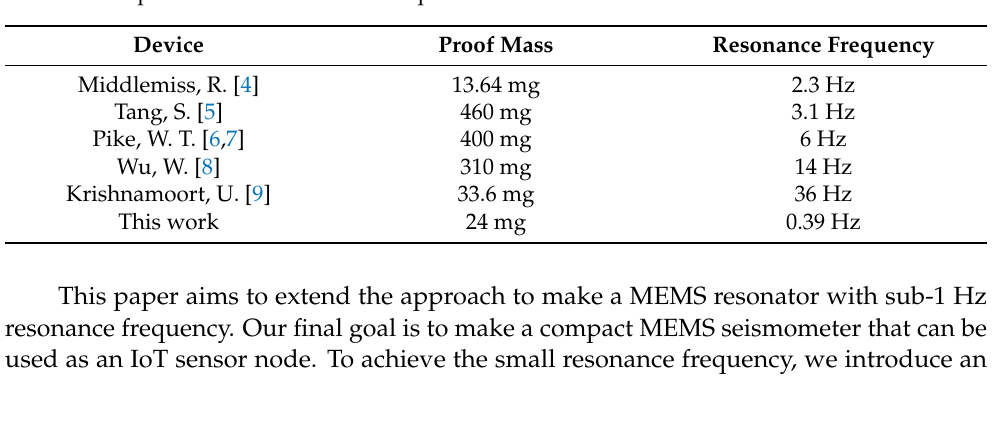
Table 1. Comparison of the resonance frequencies of conventional works and this